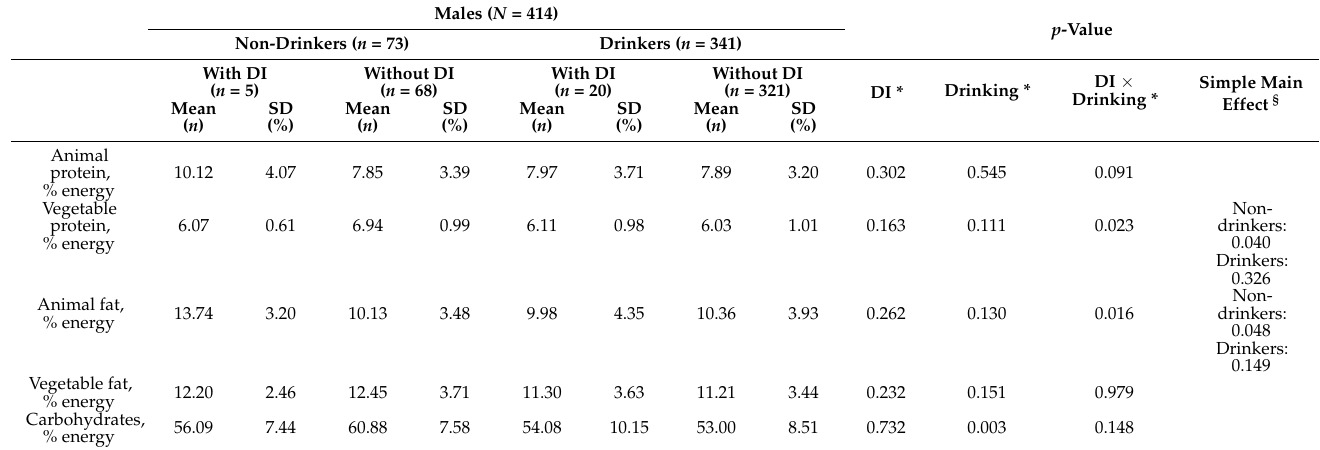
Table 3. Interactions of drinking habits and diabetes incidence on nutrient intake. Males ( N = 414)